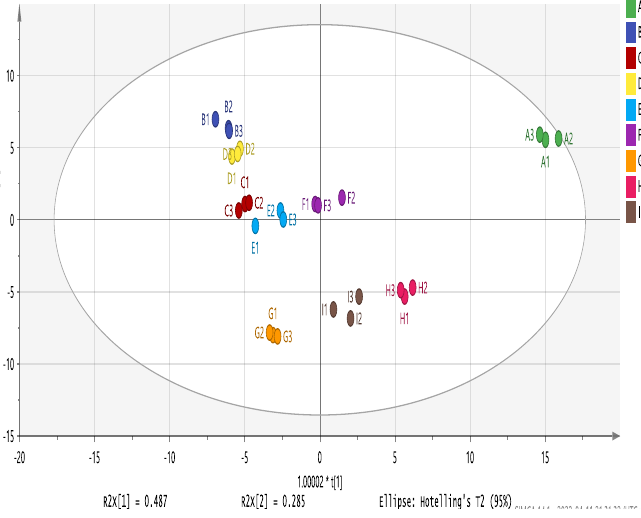
Figure 11. OPLS-DA analysis of nine wine varieties. Note: From A to I are ‘Hassan’, ‘Zuoshaner’, ‘Beibinghong’, ‘Zuoyouhong’, ‘Beta’, ‘Shuanghong’, ‘Zijingganlu’, ‘Cabernet Sauvignon’, and ‘Syrah’. Table 8. Analysis of VIP Values of Aroma Compounds in Different Varieties of Wine.